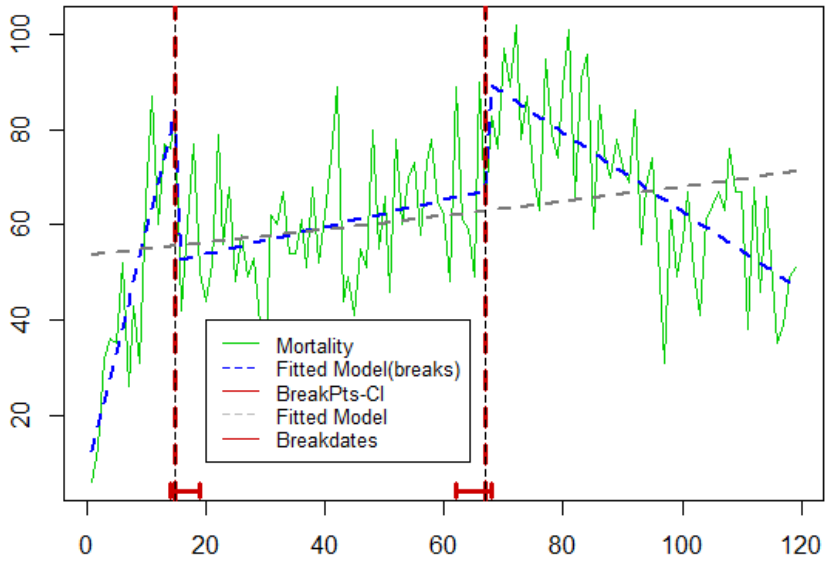
Figure 15. Road accident death data (minimal model).